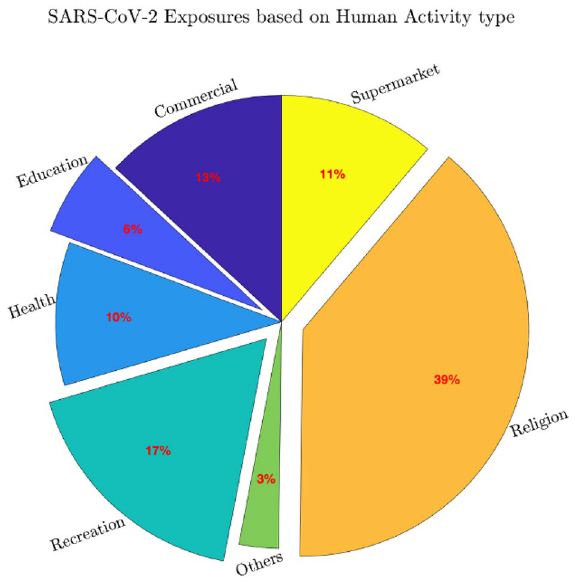
Figure 2. Pie chart describing the classification of RLSCs into human activity types.